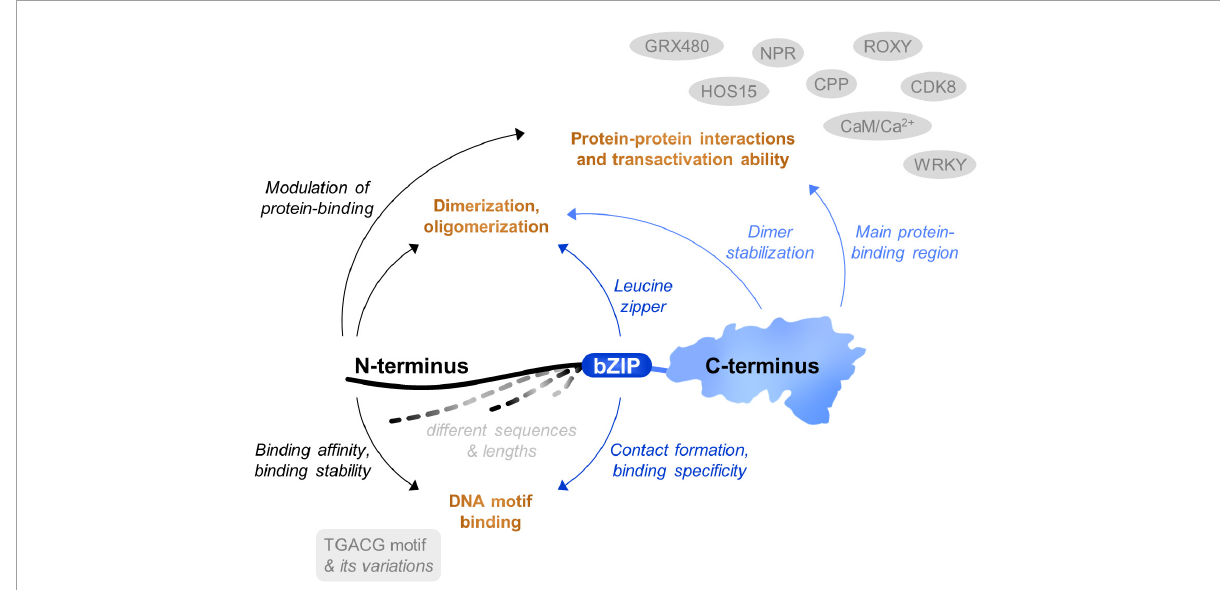
FIGURE4 Schematic representation of TGA protein parts contribution to TGA function. All three protein parts of TGAs are multifunctional, each involved in several tasks connected to their interaction with target DNA motifs, dimerization and/or oligomerization and protein-protein interactions with transcription factors, cofactors or other proteins, resulting in a specific shift in gene expression